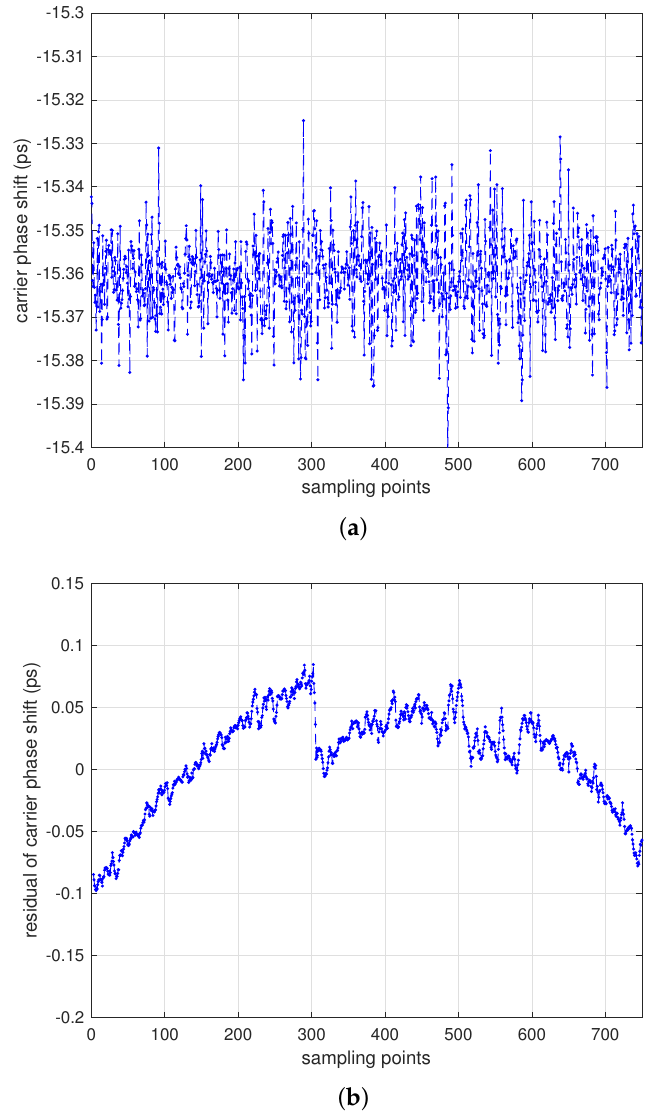
Figure 9. Carrier phase shift performance using one way ranging. ( a ) carrier phase shift results that achieved ranging accuracy of about 6 µ m/s (1 σ ). ( b ) residual obtained by the difference between the measured phase shift data and the curve from first-order